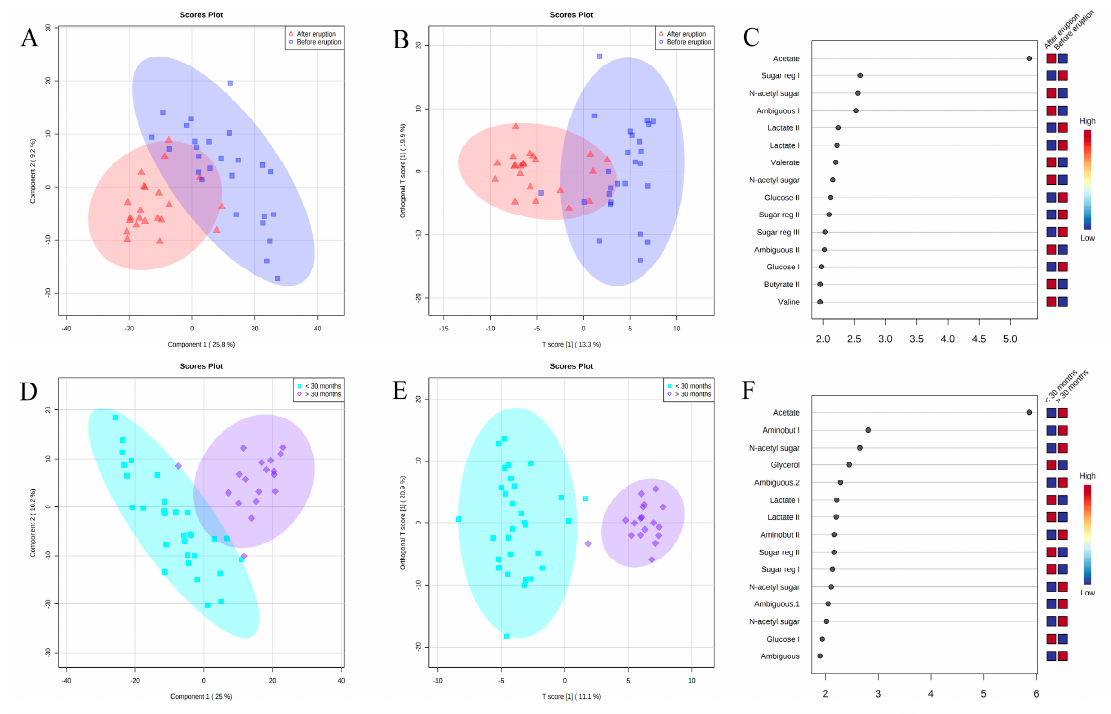
Figure 2. Multivariate analysis of NMR data. ( A ) PLS-DA and ( B ) O-PLS-DA data from children before and after dental eruption; ( D ) PLS-DA and ( E ) O-PLS-DA data from children younger vs. older than 30 months. Figure 2C,F shows VIP scores for the metabolites that were responsible for differences between the groups.